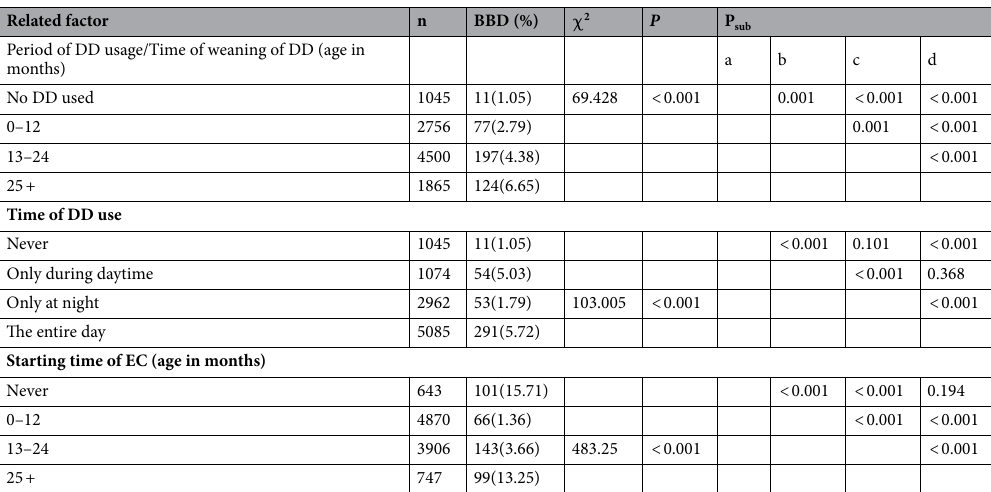
Table 2. Relationship between the prevalence of BBD and DD usage and EC. * P < 0.05 was considered statistically significant for every two subgroups. *To verify whether there were differences among the subgroups, we further conducted comparisons between each of them. The letter ‘a’ represents the first subgroup, including those who never used DDs/never engaged in EC; the letter ‘b’ represents the second subgroup, including those who used DDs for less than 12 months, used DDs only in the daytime or started EC within 12 months after birth; the letter ‘c’ represents the third subgroup, including those who used DDs for 13–24 months, used DDs only at night or started EC at 13–24 months after birth; and the letter ‘d’ represents the fourth subgroup, including those who used DDs for over 25 months, used DDs for the entire day or started EC after 24 months of age.